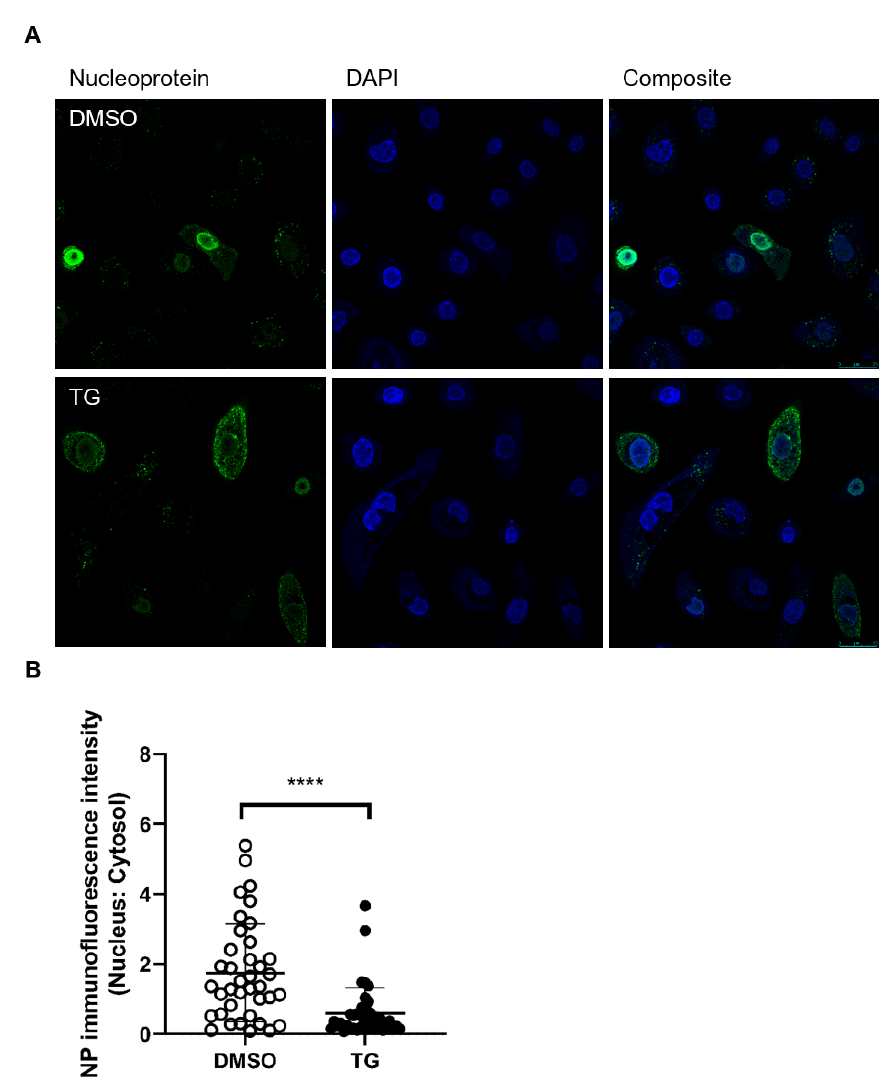
Figure 5. Cytoplasmic NP localisation in TG primed cells. ( A ) NHBE cells were primed with DMSO or 0.01 µM TG for 30 min, and infected with USSR H1N1 virus at 1.0 MOI for 6 h. Cells were immunostained for viral NP (mouse anti-influenza A virus NP primary antibody detected by donkey anti-mouse IgG H&L conjugated to Alexa Fluor 488 secondary antibody; green fluorescence) and nuclei were stained with DAPI (blue fluorescence). Cells imaged with a Leica TCS SP8 confocal microscope using a 63-time oil immersion objective (scale bar: 25 µm). ( B ) The ratio of nuclear to cytoplasmic NP fluorescence signal in DMSO and TG-primed NHBE cells was calculated using Fiji (image J). Significance determined by Mann Whitney test, relative to indicated DMSO control. **** p < 0.0001.